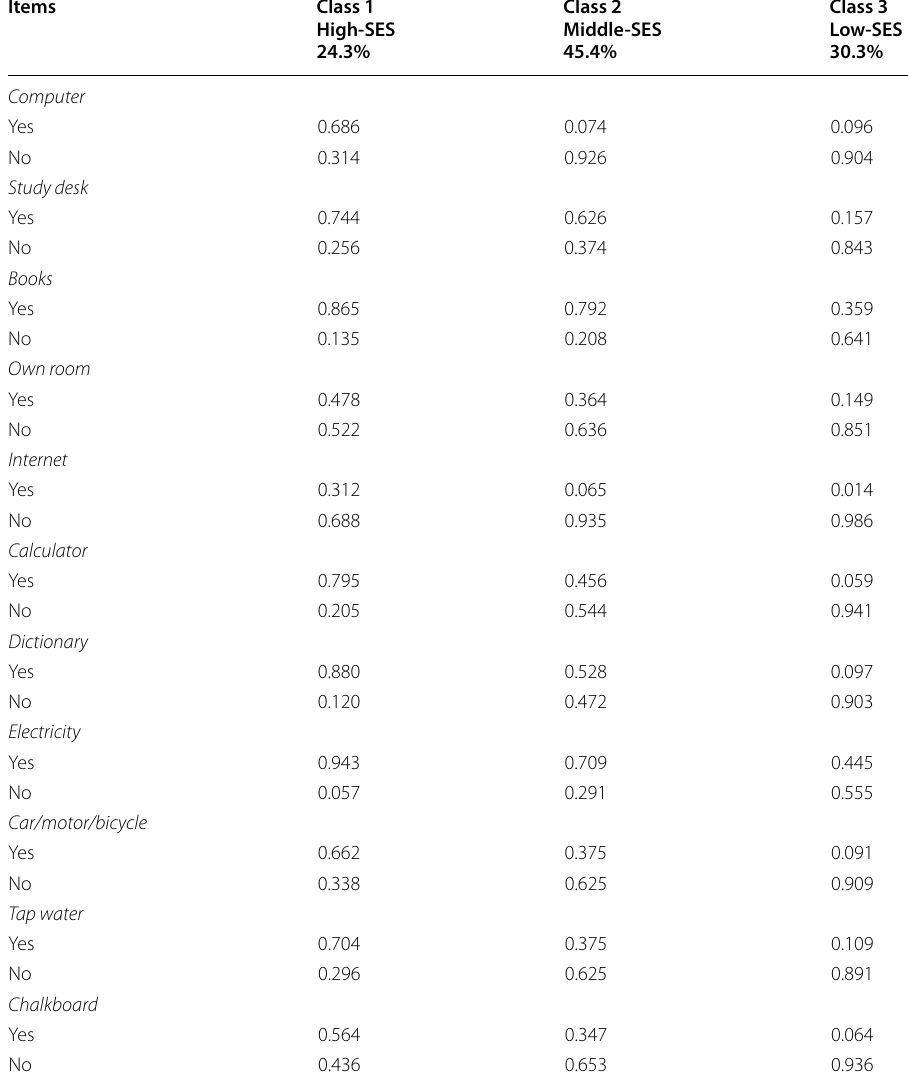
Table 3 Latent class probabilities for the three SES classes